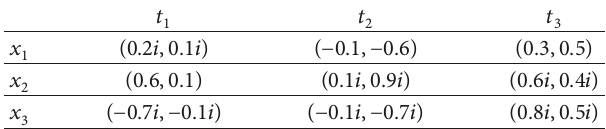
Table 3: TCIFS A